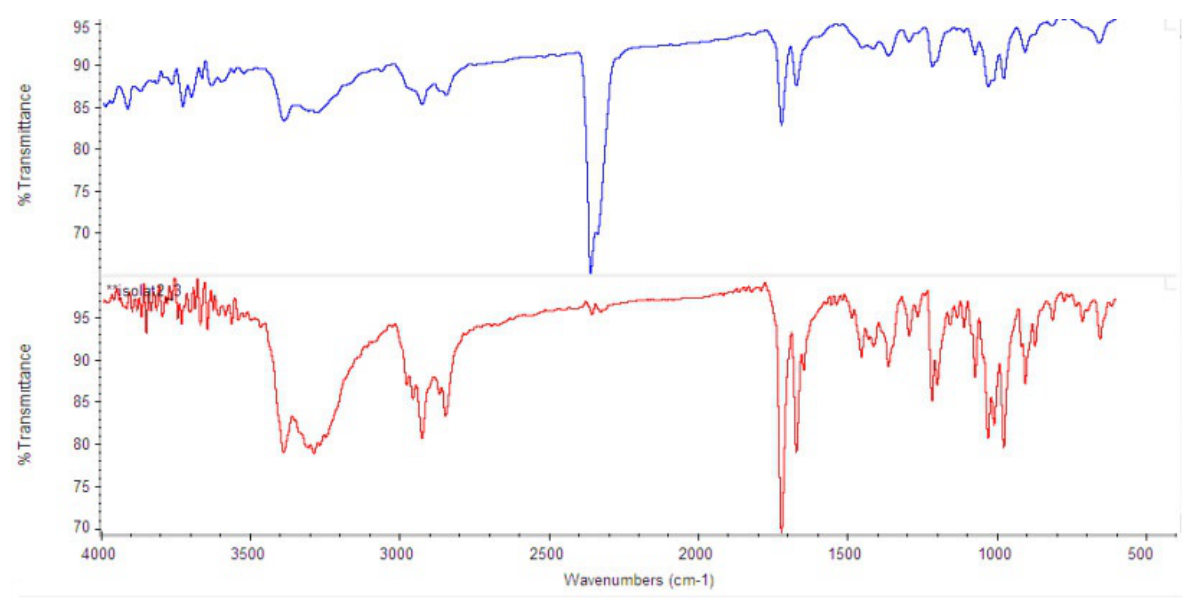
Figure 10. FTIR spectrum of andrographolide standard (blue) and isolate (red).